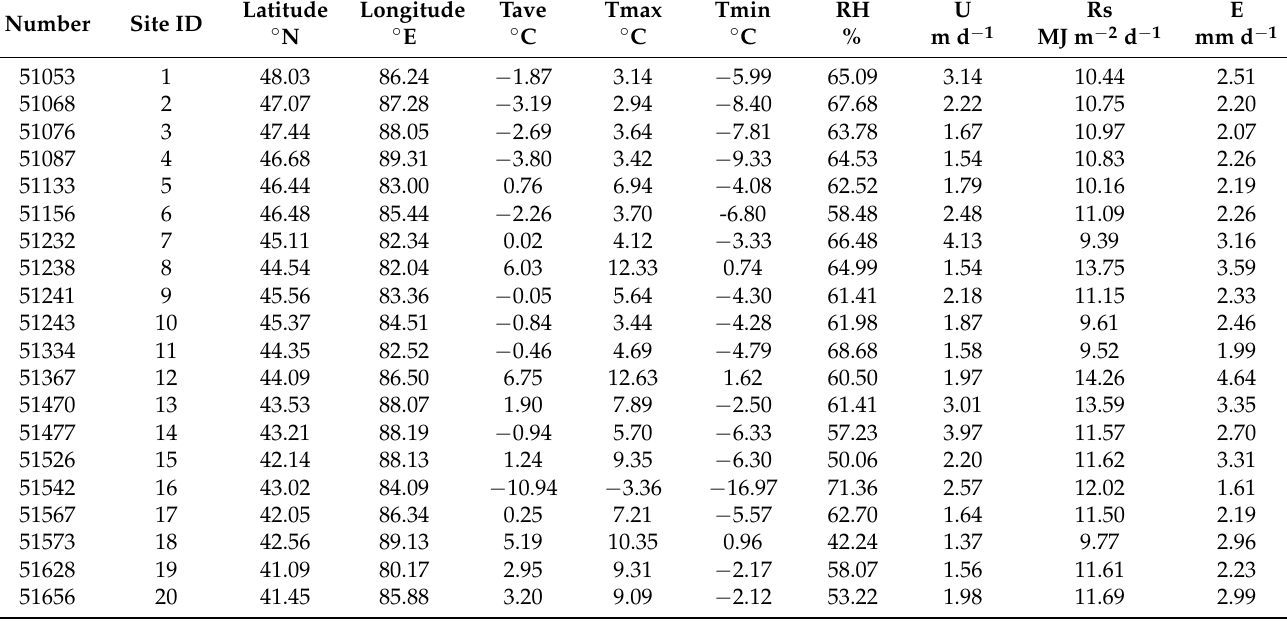
Table 1. Geographical and meteorological information of the 45 stations selected for this